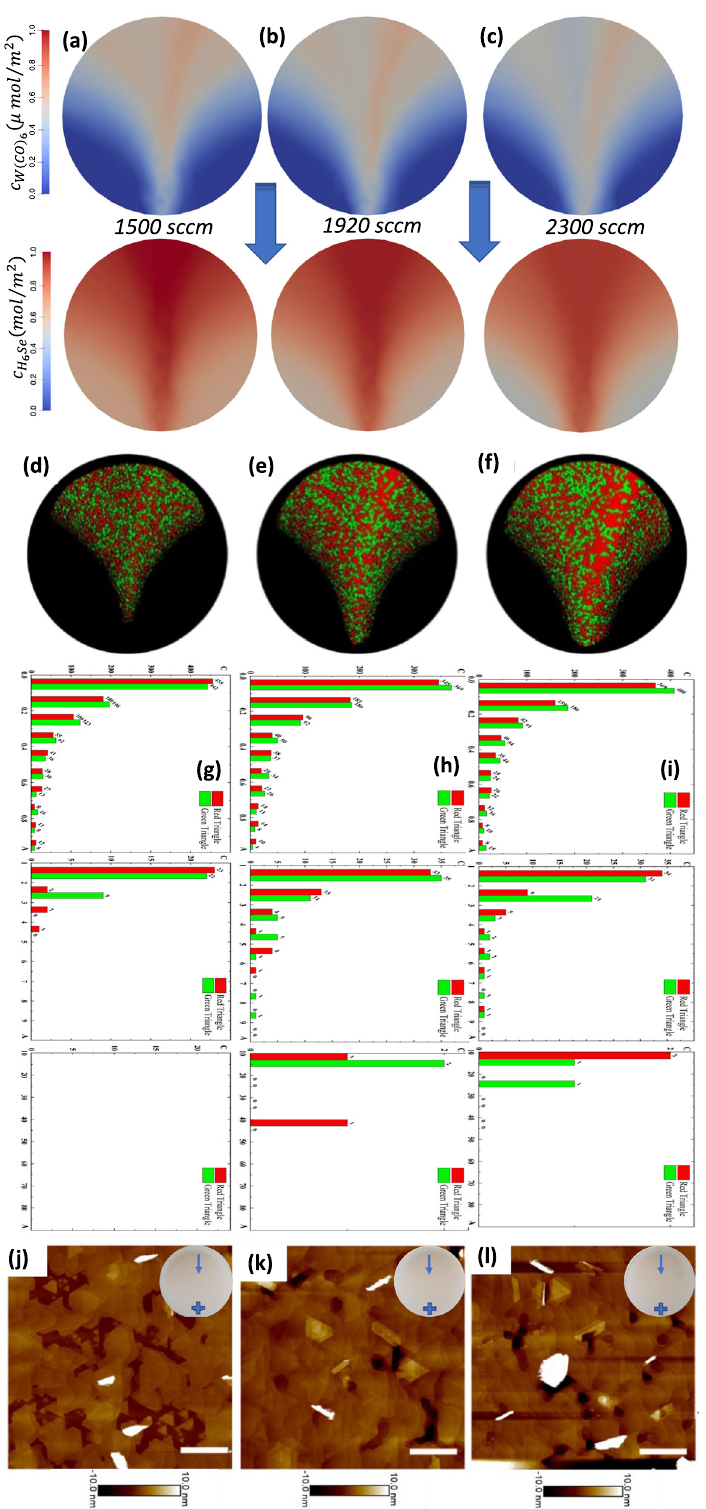
Fig. 4 Effect of inlet gas velocity on coverage. Concentration distributions of W(CO) 6 (top) and H 2 Se (bottom) are shown for carrier gas inlet of 1500 sccm ( a ), 1920 sccm ( b ), and 2300 sccm ( c ). Corresponding PF simulations ( d – f ) and their distribution analysis ( g – i ) are shown. Colors show different island orientations. The abscissa shows island area (designated A) while the ordinate shows island count in each bin (labeled with C). The AFM measurements of as grown WSe 2 ( j – l ) at the point marked by ‘ + ’ are shown on the optical images of the substrate (inset fi gures). Arrows designate the direction of the gas fl ow. Our results demonstrate improved growth coverage by increasing the inlet carrier gas fl ow, which saturates at higher